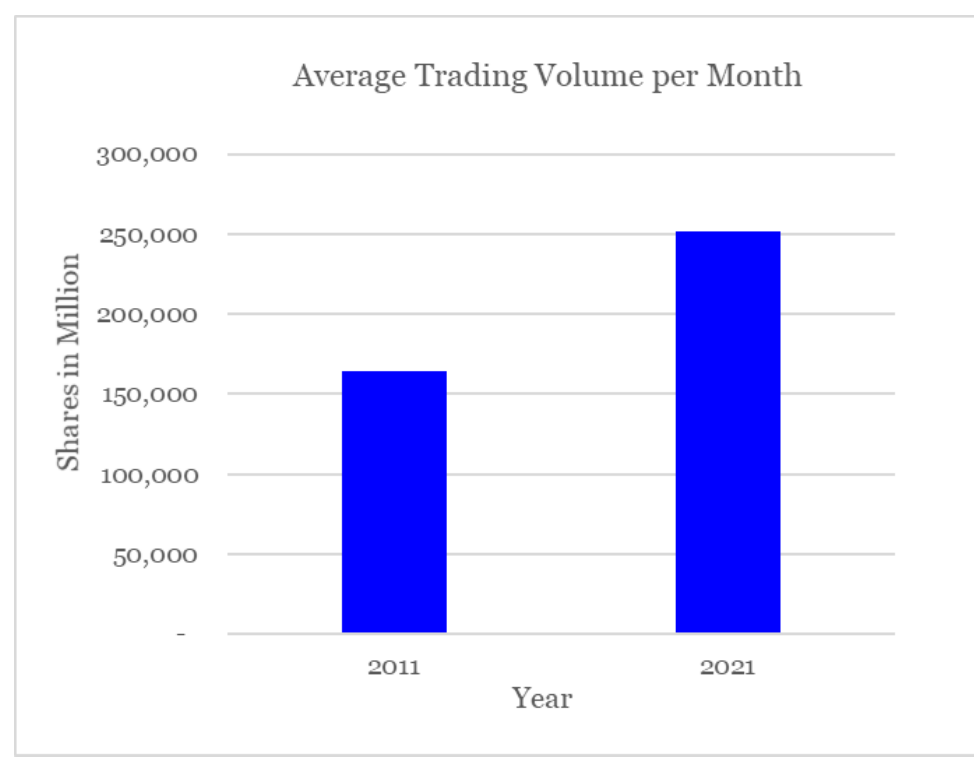
Figure 1. Change in trading volume in 2011 vs. 2021. This figure plots the average number of shares executed in the overall market per month in 2011 and 2021. The data was taken from the CBOE’s U.S. Equities Market Volume Summary (https://www.cboe.com/us/equities/market_share, accessed date: 20 August 2021).